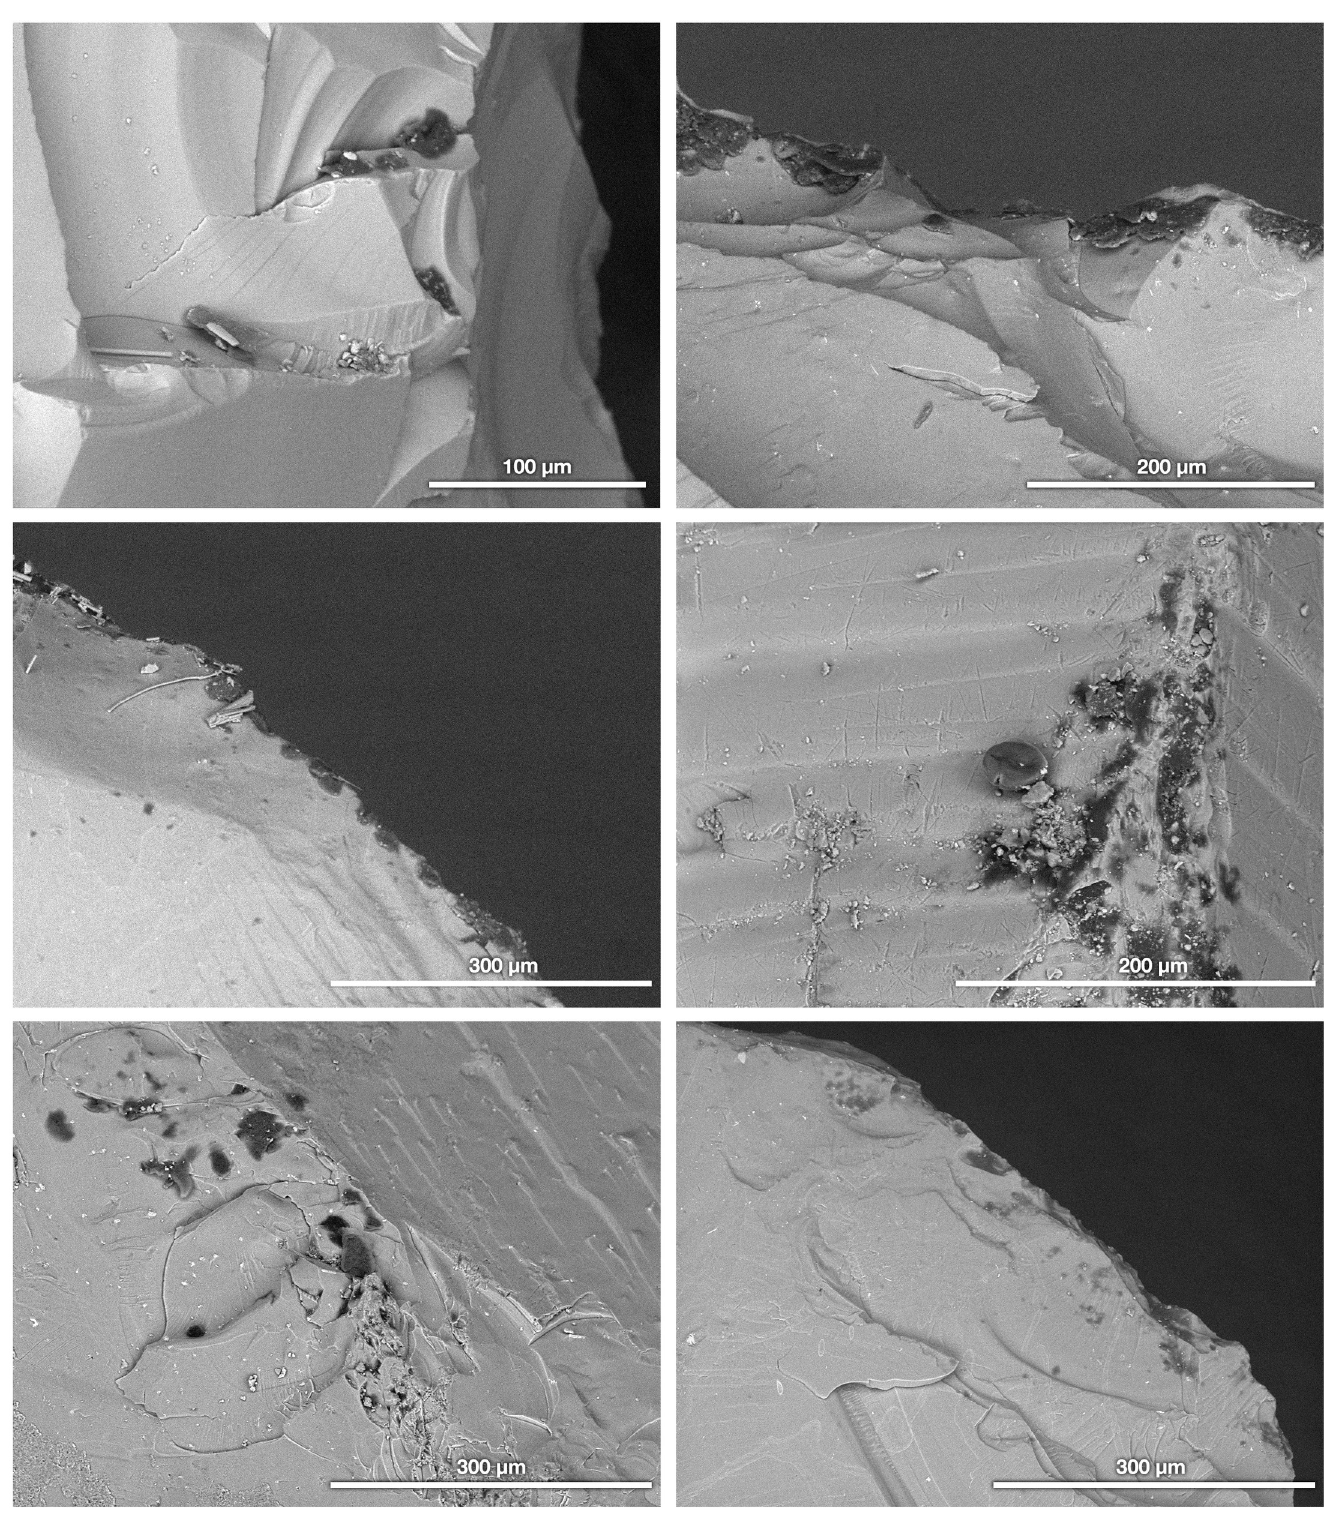
Fig 2. SEM-BSE images. Examples of organic residues (dark patches) on LKT1 lithic artifact surfaces. Images by the joint main authors (EF and GM).